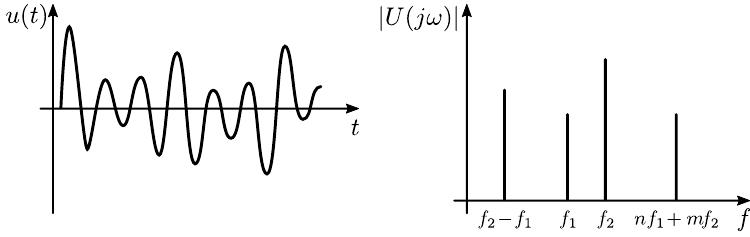
Figure 4. Ferroresonance characteristics for quasi-periodic